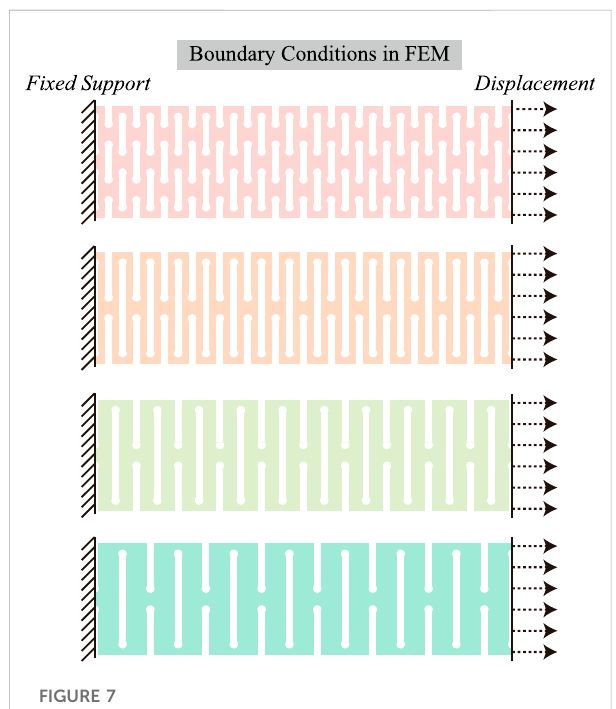
FIGURE 7 Schematic diagram to present experimental setup in FEM. Boundaryconditions( fi